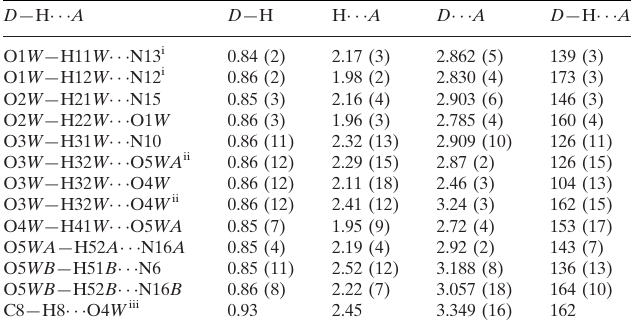
Data collection: CrysAlis CCD (Oxford Diffraction, 2007); cell refinement: CrysAlis RED (Oxford Diffraction, 2007); data reduc- tion: CrysAlis RED ; program(s) used to solve structure: SHELXS86 (Sheldrick, 2008); program(s) used to refine structure: SHELXL97 (Sheldrick, 2008); molecular graphics: Mercury (Macrae et al. , 2006); software used to prepare material for publication: WinGX (Farrugia,